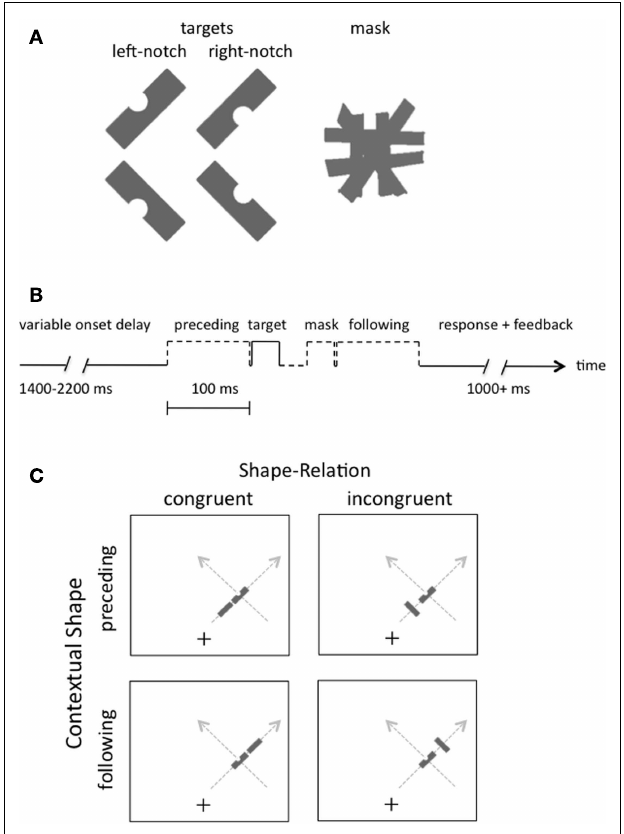
FIGURE 1 | (A) Illustration of the four possible target shapes and the pattern mask in the experiments. Participants reported whether the target had a notch on the left or the right side, regardless of its slant. (B) Illustration of the sequence of events on each trial. (C) Illustration of the displays in Experiment 1. Gray arrows indicate the two possible motion directions on the right side of the screen; equivalent paths were possible on the left side (not